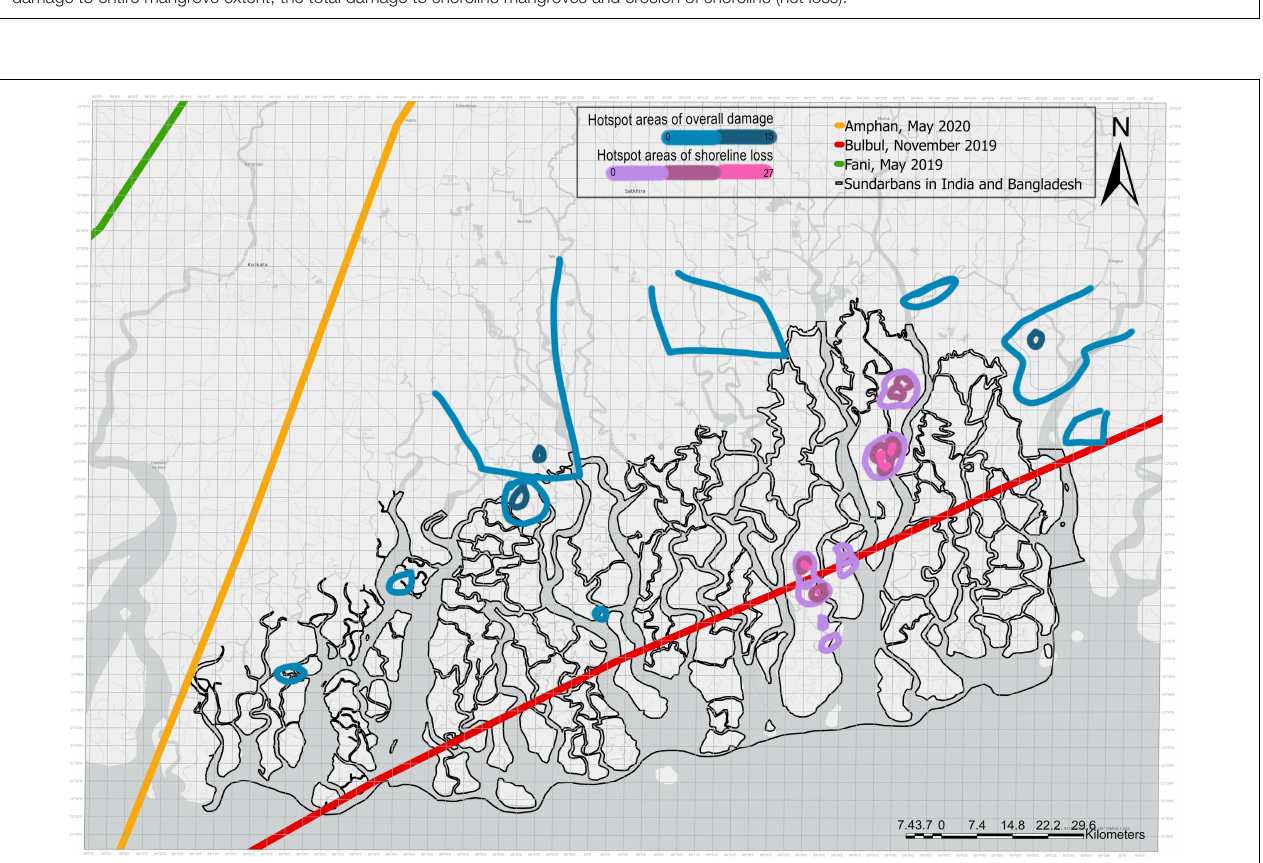
FIGURE 4 | Spatial distribution of hotspot areas of damage (entire mangrove and shoreline) and shoreline loss (erosion) in the Sundarbans as a cumulative impact of Cyclone Amphan, Bulbul, and Fani. The white dot in the inset image is the location of the Sundarbans in India and Bangladesh. The color scale ranging shows the hotspot areas of mangrove forest area damage throughout the Sundarbans and loss along with the shoreline areas. The orange areas show areas with higher cumulative damages across the three cyclones and the pink areas show higher cumulative losses in the shorelines areas across the three cyclones. The scale is a unitless normalized value based on loss in the area. This image is a simplified version of a 10,000 km 2 area. The hotspot areas that appear inland, are along river channels.